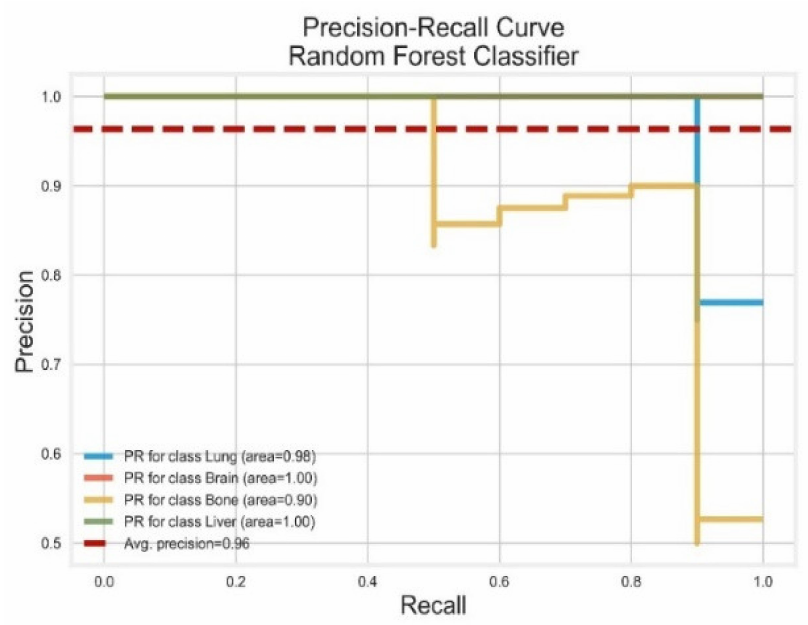
Figure 19. Precision-Recall Curve (Random Forest Classifier).